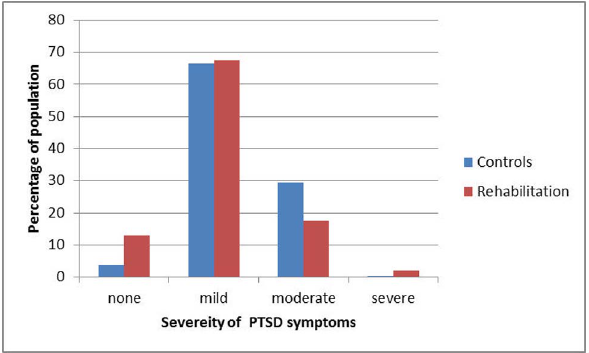
Figure 1. Categorized Post-taumatic Stress Disorder Symptoms accross Study Groups (X 2 =20.56, p , 0.001).